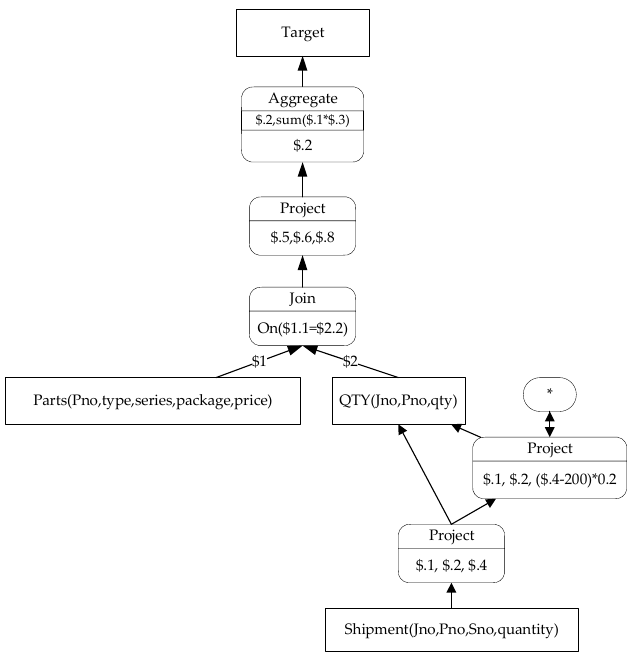
Figure 6. SPGraph of the query 𝑄 (cid:2870) .